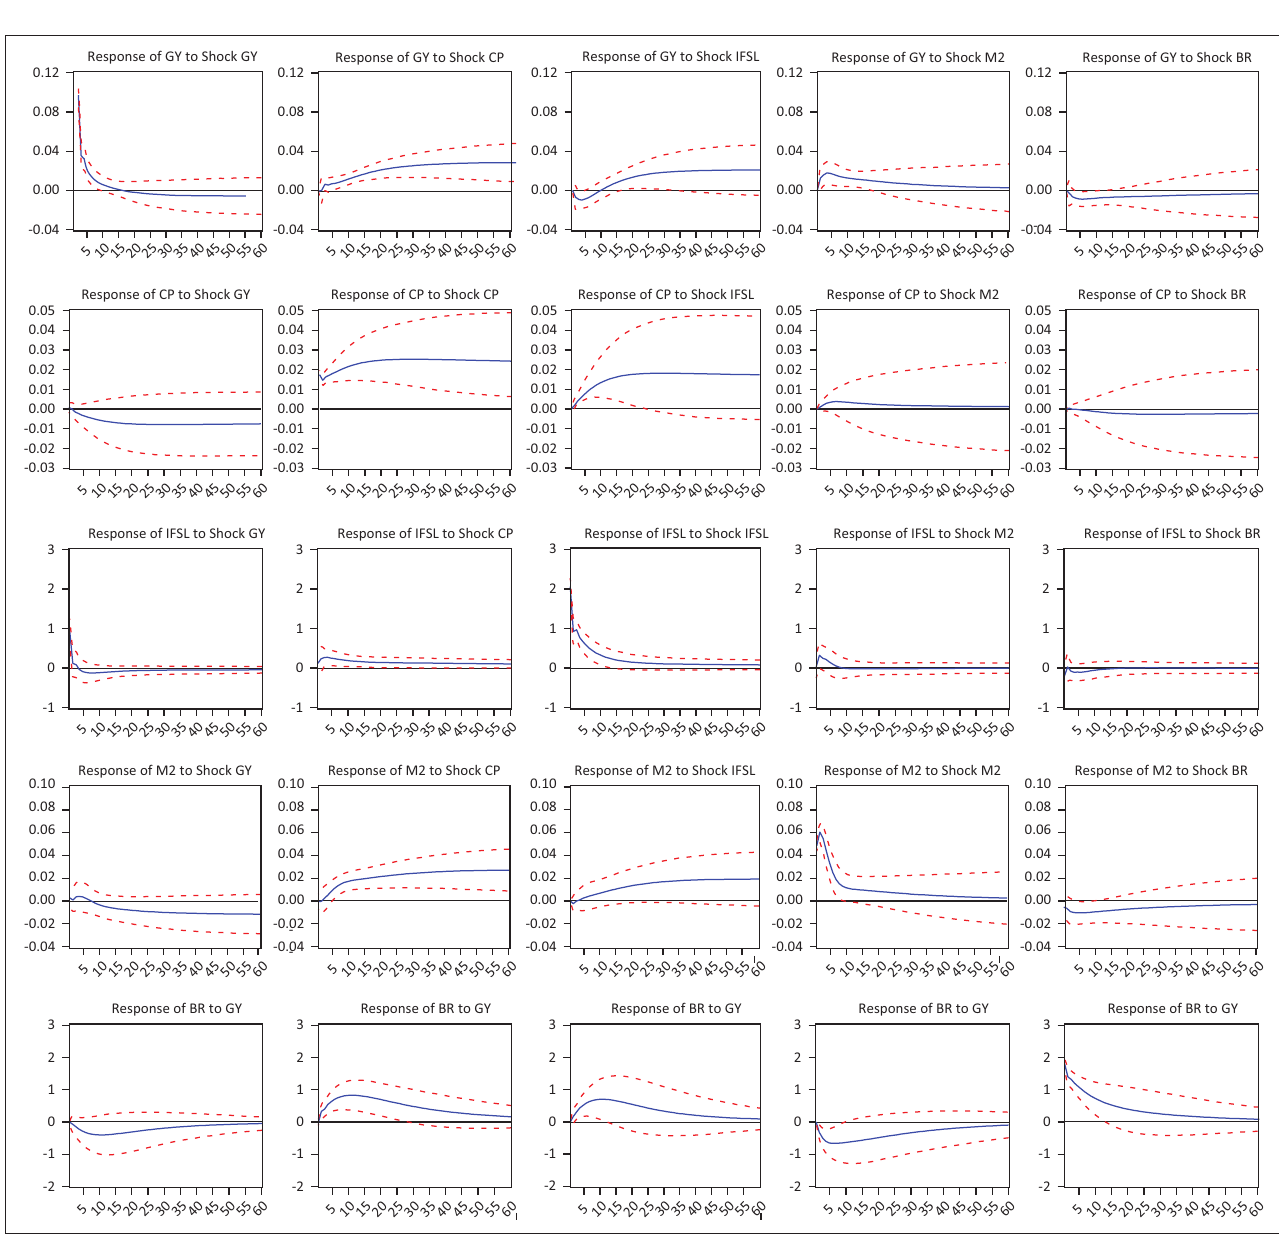
FIGURE 2-A1: Impulse responses with informal financial sector